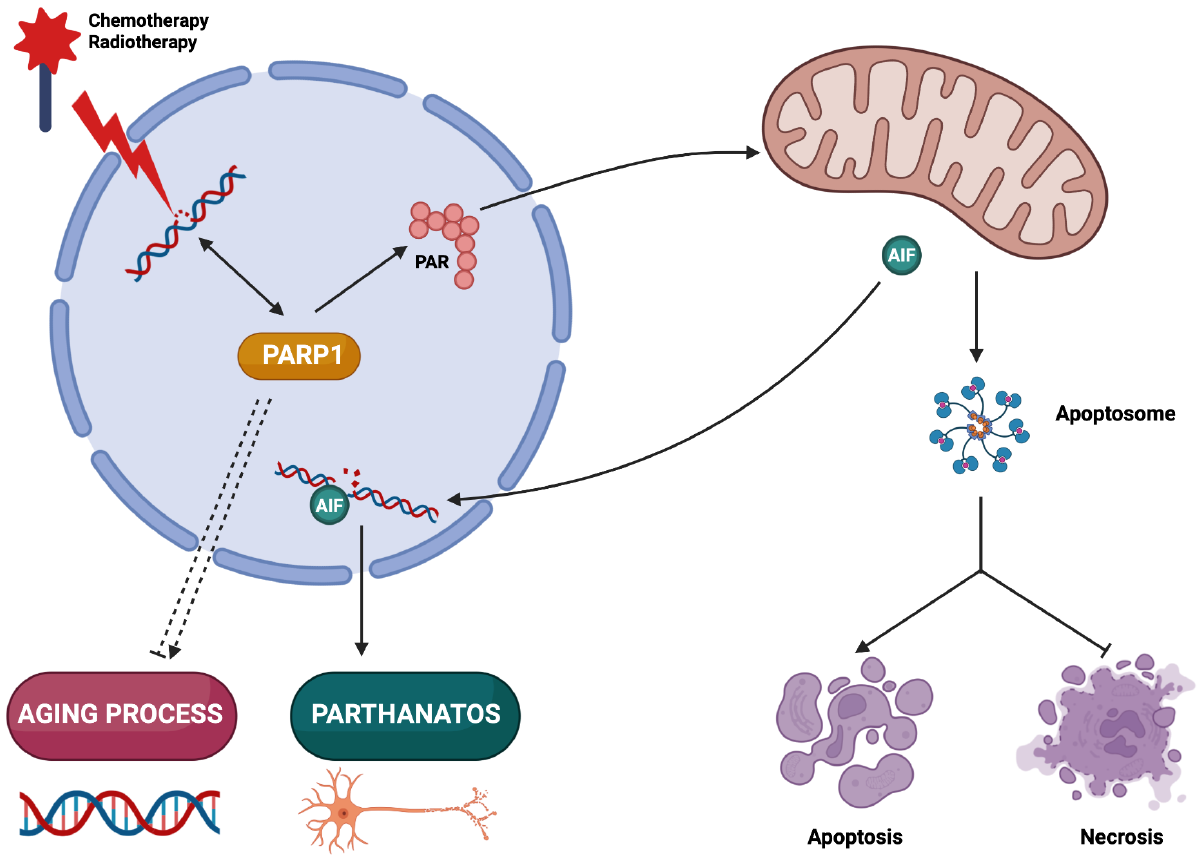
FIGURE 1. PARP1 context-dependent functions in cellular life and death. Poly(ADP-ribose) polymerase-1 (PARP1) is a DNA repair enzyme activated in cancer cells treated with DNA damaging agents, and pharmacological PARP1 inhibitors can be used to improve chemotherapy and radiotherapy efficacy. PARP1 inhibition may also have neuroprotective effects by decreasing parthanatos-induced neuronal death. However, the ambivalent role of PARP1 in organismal aging and cell death modalities should be considered in view of the possible side ef- fects of long-term treatments with PARP1 inhibitors. PARP1, Poly(ADP-ribose) polymerase-1; PAR: Poly(ADP-ribose); AIF: apoptosis inducing